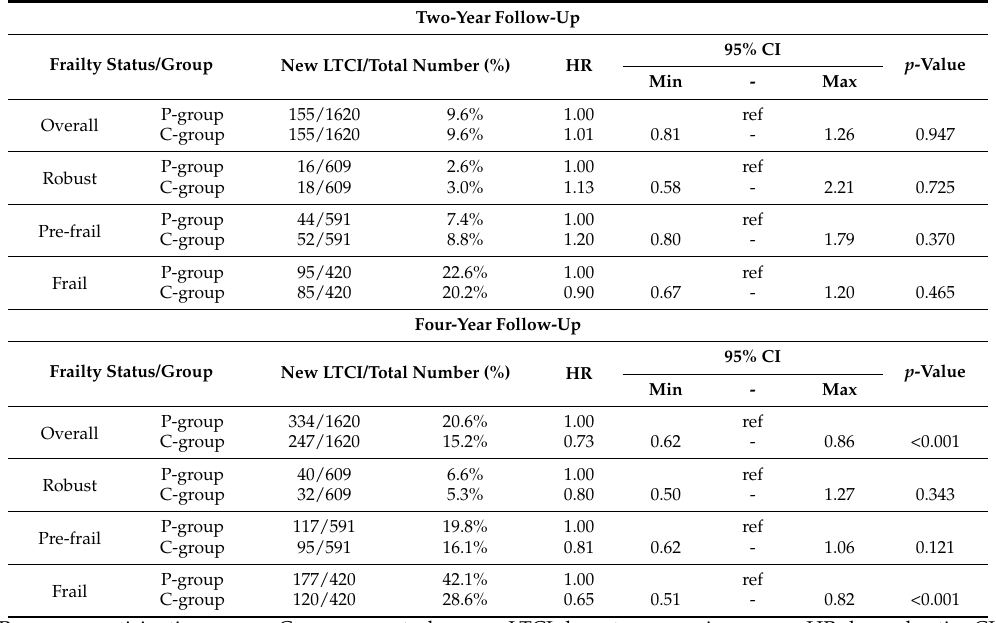
Table 2. Cox proportional hazards models of each group for new LTCI service requirement certifications during the two- or four-year follow-up period.